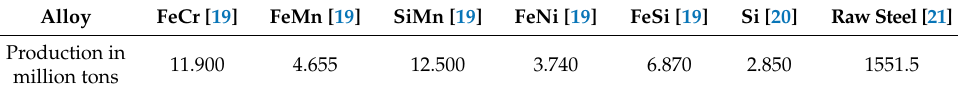
Table 1. Production figures of some alloys for 2016 in million tons, excluding the USA.